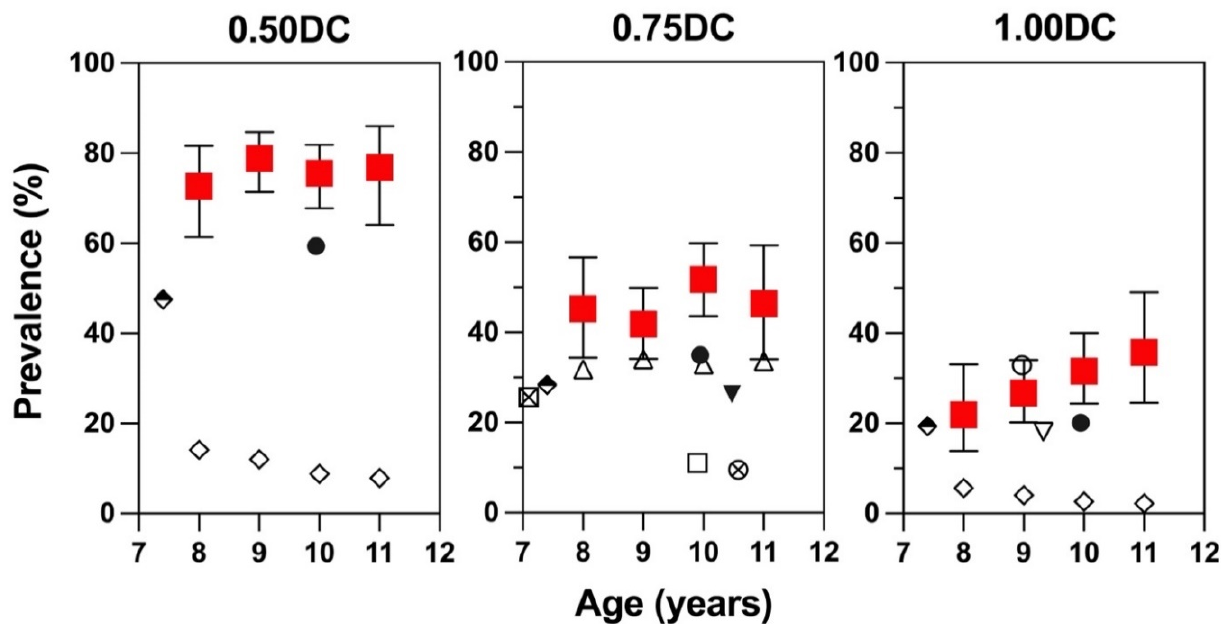
Figure 2. Comparison of prevalence rates of astigmatism in this study ( red filled square ) with control data in Hong Kong ⚫ [12]; [22] and other Asian Chinese populations, including Singapore ⬘ [11], Taiwan [20] , and Mainland China [6]; [7]; [8]; [9]; [10]; [21]. Only recent studies conducted on Asian Chinese population that consistently used either right eye or left eye to report the prevalence of astigmatism were included. Prevalence rates of various studies were stratified into three columns according to their definitions of astigmatism (Cyl ≥0.50, 0.75, and 1.00 DC). Note that data from Choi et al. 2017 [12] were not published but obtained via personal communication with the authors.